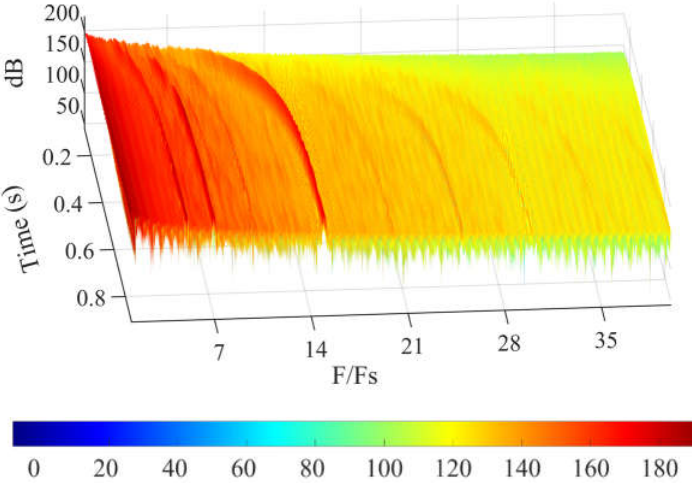
Figure 22. Time–frequency characteristics of pressure at the volute.